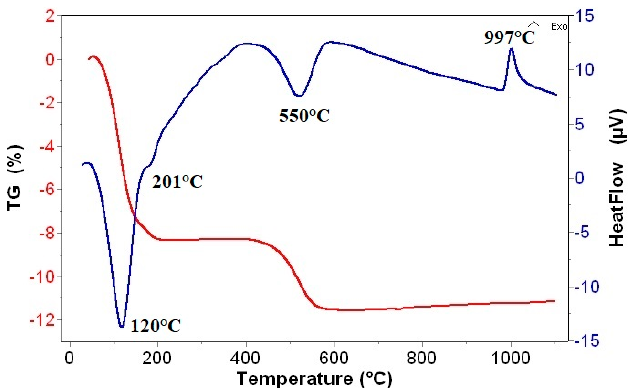
Figure 7. TG/DTA curve of BEI.